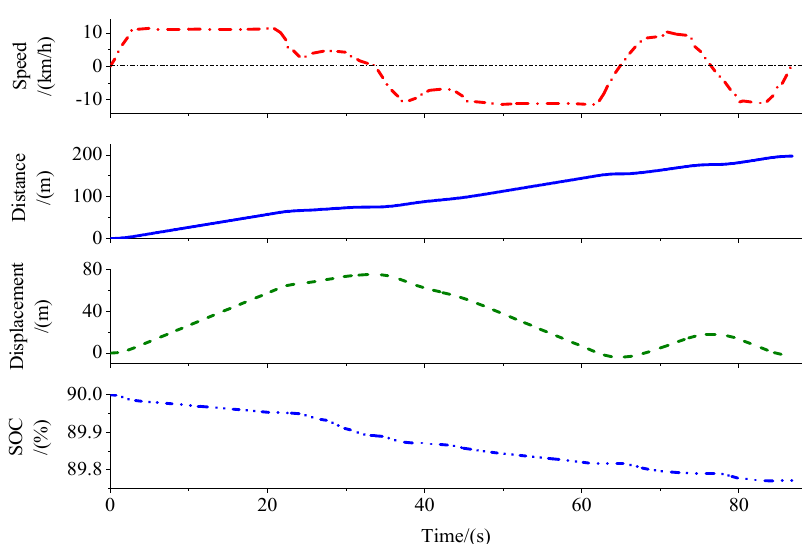
Figure 19. Machine mass–time data.